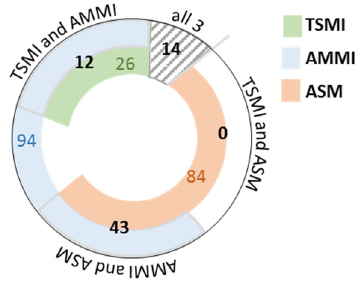
Figure 4. Comparison of the number of sarcopenic individuals identified by ASM-based indices and ASM. Each partial circle depicts an index or ASM. The number in the partial circles indicates the number of individuals recognised as sarcopenic per index. The black numbers reaching over two differently coloured partial circles represent the number of individuals recognised by the two compared parameters. The striped area shows the number of persons identified as sarcopenic, according to all three compared parameters. TSMI: total skeletal mass index; AMMI: appendicular skeletal muscle mass index; ASM: appendicular skeletal muscle